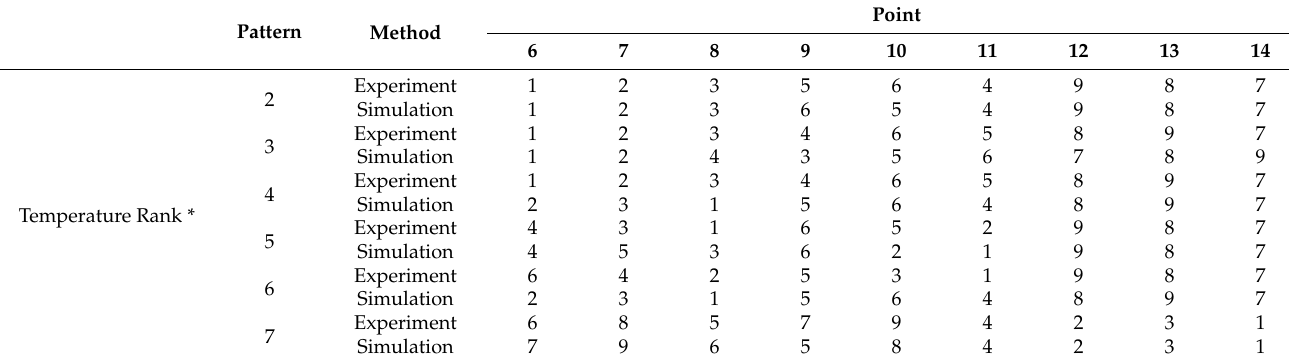
Table 7. Ranking for the lowest center temperature in the boxes depending on loading